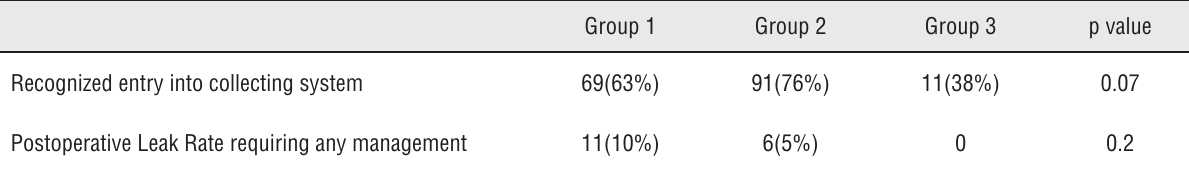
Table 3 - Leak rates and entry into collecting